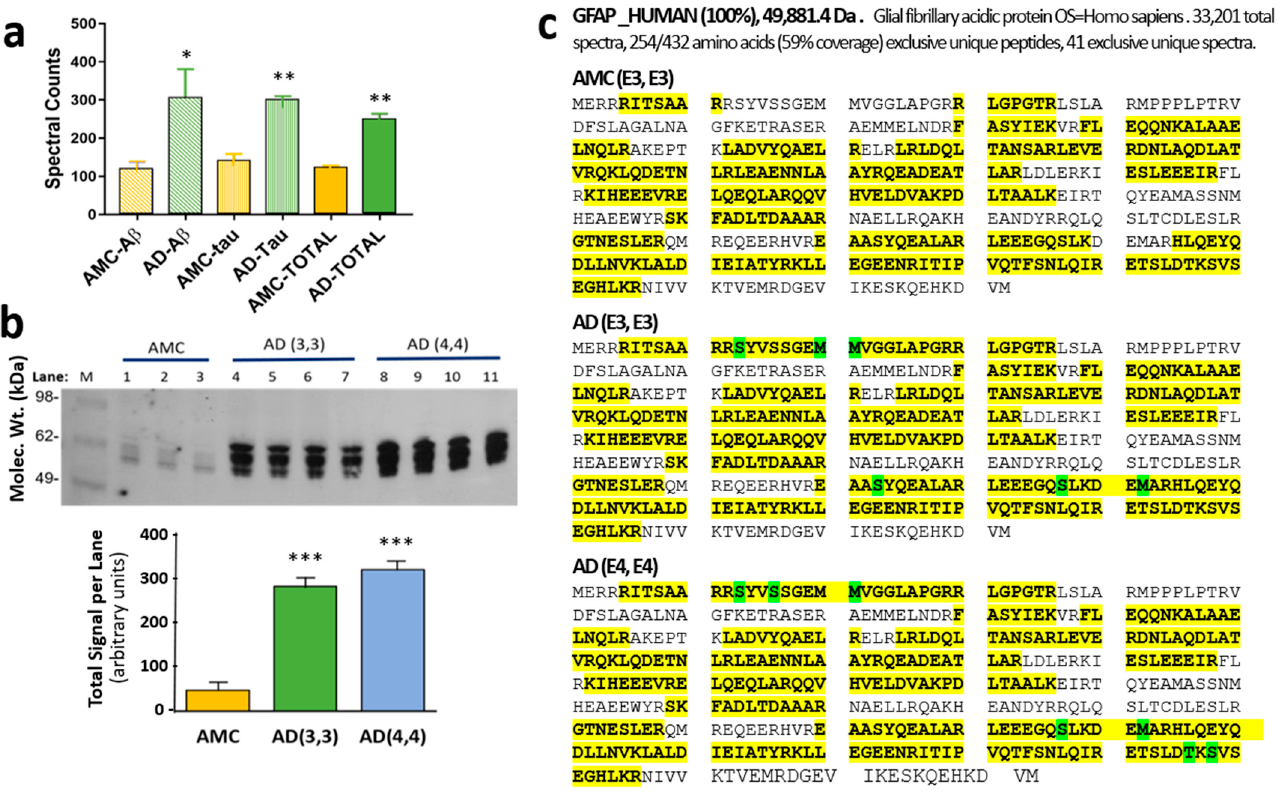
Figure 1. GFAP is more abundant and more modified in AD aggregates than in AMC. ( a ) Spectral counts for GFAP in sarkosyl-insoluble aggregates isolated by immuno-pulldown (IP) of A β or tau, or in total aggregates without IP, from human AD vs. age-matched-control (AMC) hippocampus. AD differs from AMC according to heteroscedastic t -tests: * p < 0.05; ** p < 0.005. ( b ) Western blot of phosphorylated GFAP from AMC(3,3) vs. AD(3,3) or AD(4,4) hippocampal aggregates, detected with antibody to phospho-GFAP (Ser13; ThermoFisher). *** Each AD group differs from AMC according to two-tailed heteroscedastic t -test at p < 0.0001. ( c ) Differential post-translational modifications (PTMs: phosphorylation of S er or T hr residues, or oxidations of M et) observed in GFAP isolated from AMC [ApoE(3,3)], AD [ApoE(3,3)], or AD [ApoE(4,4)] hippocampus, as indicated. Peptide coverage is indicated by yellow highlighting, including PTMs indicated by green highlighting.